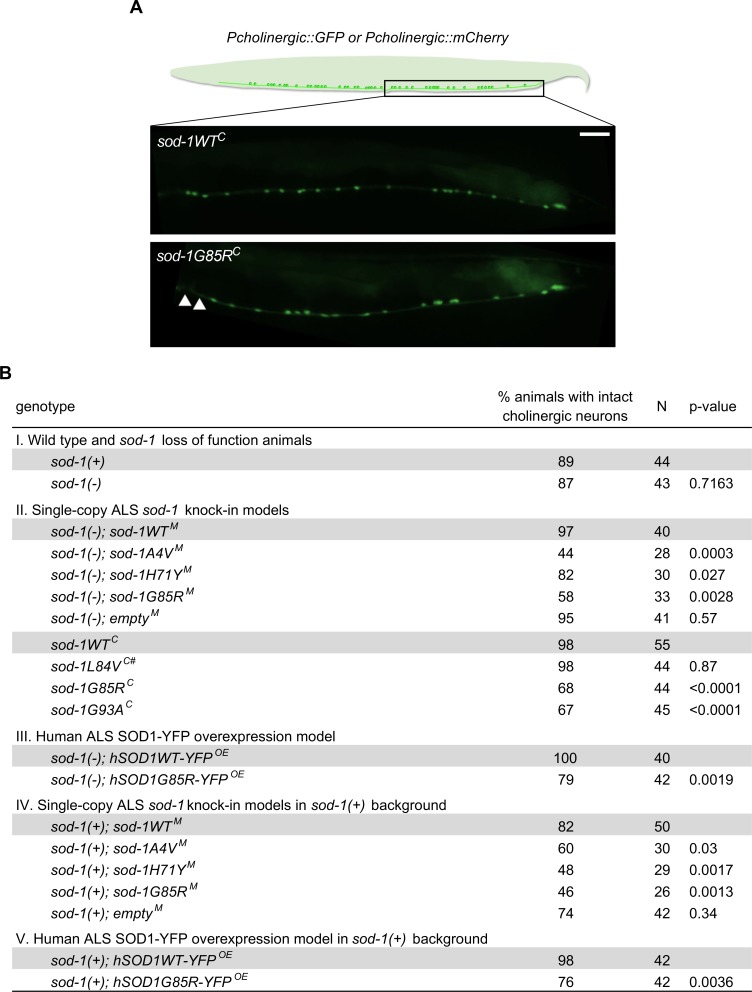
Gain of toxic function in sod-1 drives oxidative stress induced cholinergic motor neuron degeneration in single-copy/knock-in ALS sod-1 animals.(A) Cartoon illustration (top) and representative images (bottom) of cholinergic motor neurons posterior to vulva scored in neurodegeneration assays after overnight exposure to 2.5 mM paraquat-induced oxidative stress. Cholinergic motor neurons were visualized with [unc-17p::GFP], except for human SOD1-YFP overexpression strains, which express YFP and were therefore scored with [cho-1p::mCherry]. Animals missing at least two neurons were scored as defective. White arrows point to missing neurons. N = number of animals tested. Chi-square test: * P < 0.05, ** P < 0.01, ** P < 0.001. (B) Animals were compared to appropriate wild type controls shown in the first row of each section. Cholinergic motor neurons were lost in sod-1H71YM, sod-1G85RM, sod-1G93AC, sod-1G85RC and hSOD1G85R-YFPOE animals, but not in animals lacking sod-1 function (emptyM controls and sod-1(-)) or in sod-1L84VC animals (indicated with #). Presence of the endogenous wild type sod-1(+) allele in single-copy/knock-in models or in hSOD1G85R-YFPOE overexpression models did not improve cholinergic motor neuron survival. sod-1(+) designates the unedited wild type gene at the endogenous locus; this is the same allele present in standard N2 strain.